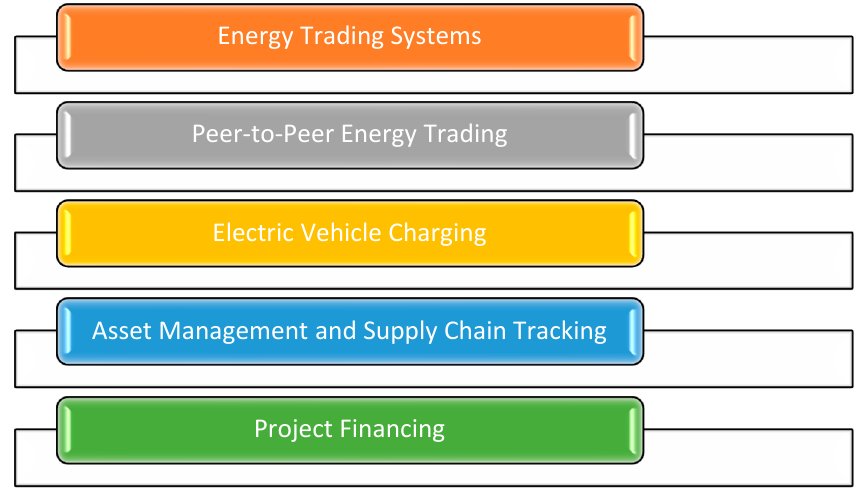
Figure 2. Blockchain-based key energy applications.